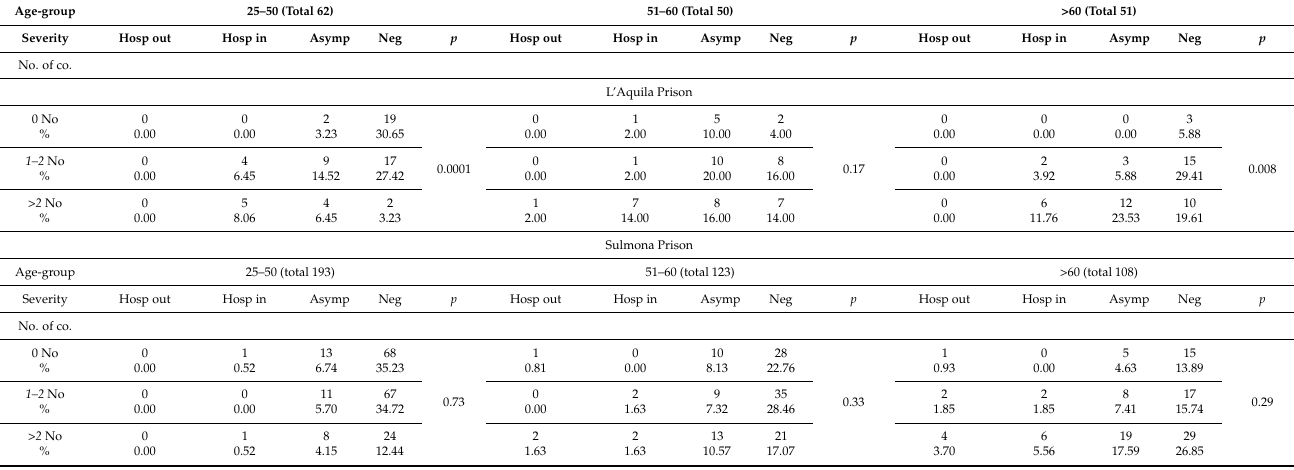
Table 3. Association between the number of comorbidities and the severity of COVID-19 disease stratified by age